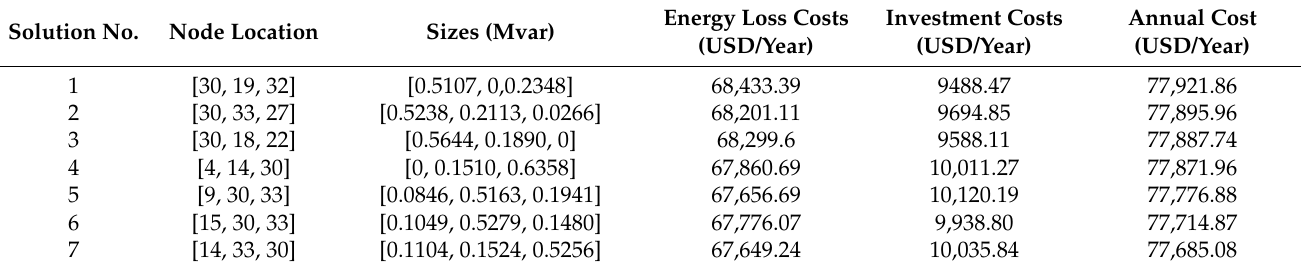
Table 7. Results obtained by the metaheuristic optimizers and the proposed methodology for the meshed